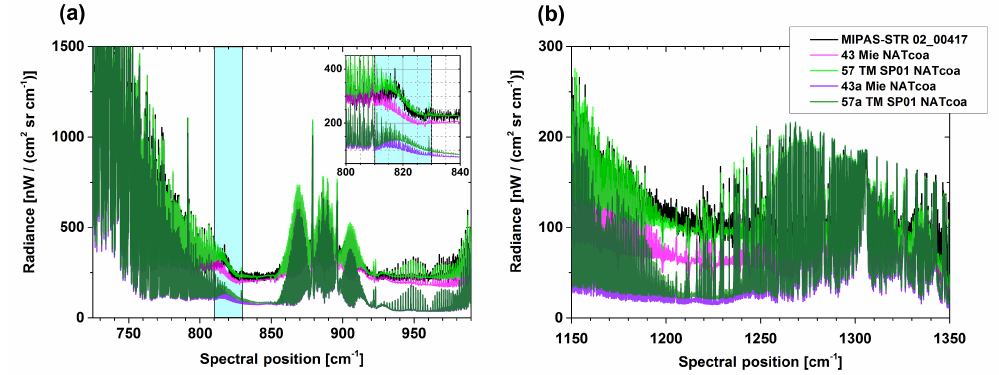
Figure 14. Relative roles of emission and scattering by spherical particles and highly elongated spheroids consisting of β -NAT. Black: MIPAS-STR limb observation (13:47UTC, tangent altitude 18.4km). Magenta/violet: simulations of spherical particles (AR = 1.0) with/without scattering. Green/dark green: simulations of highly elongated particles (AR = 0.1) with/without scattering. Numbers in the legend refer to scenarios in Table 1. “NATcoa” corresponds to β -NAT, “Mie” to Mie simulation, “TM” to T-matrix simulation, and “SP” to spheroid (numbers indicate